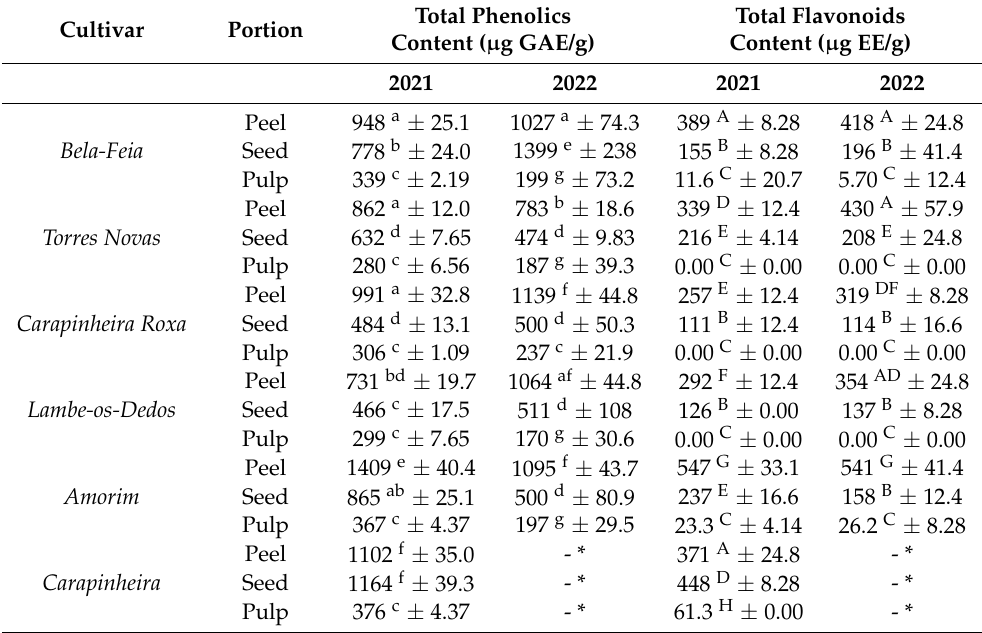
Table 5. TPC and TFC of different portions of pear cultivars. Results are expressed in means ± standard